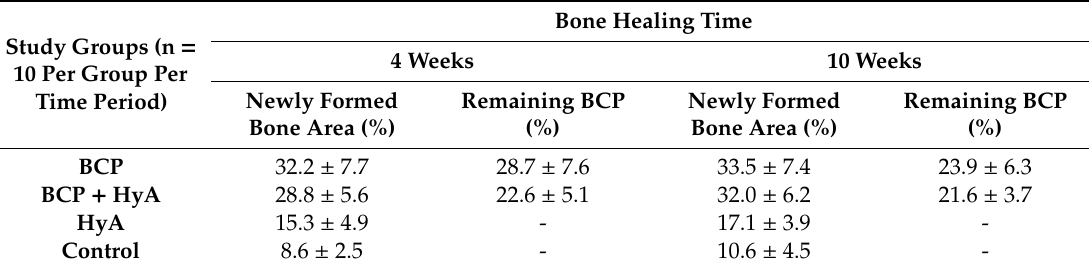
Table 1. Quantitative (mean ± SD) histomorphometrical evaluation of newly formed bone area (%) and remaining BCP (%) in the different groups during the two time periods of evaluation.